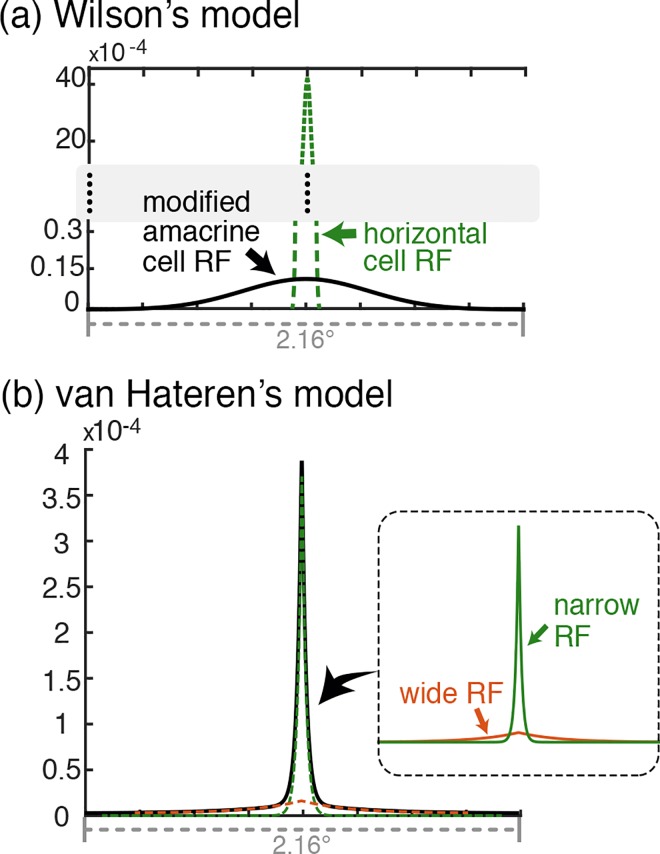
Illustration of the wide RF profiles in the retinal models.(a) Wilson’s model. The amacrine cell wide RF profile (solid black line) is a modification introduced in this study. The dotted green line shows the horizontal cell filter profile (narrow RF) in the same scale for comparison. (b) The horizontal cell narrow + wide RF in van Hateren’s model (the RF structure is directly taken from [30]). The solid black line illustrates the actual dual-component RF profile and the dotted lines in the plot and the solid lines of the corresponding colors in the inset separately shows the narrow (green) and the wide (red) components for comparison.